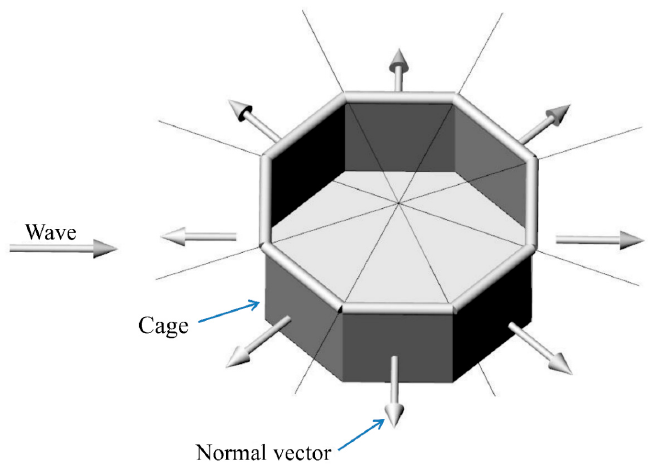
Figure 3. The cage net modeled in the form of an octagonal column for the calculation of net resistance to wave.